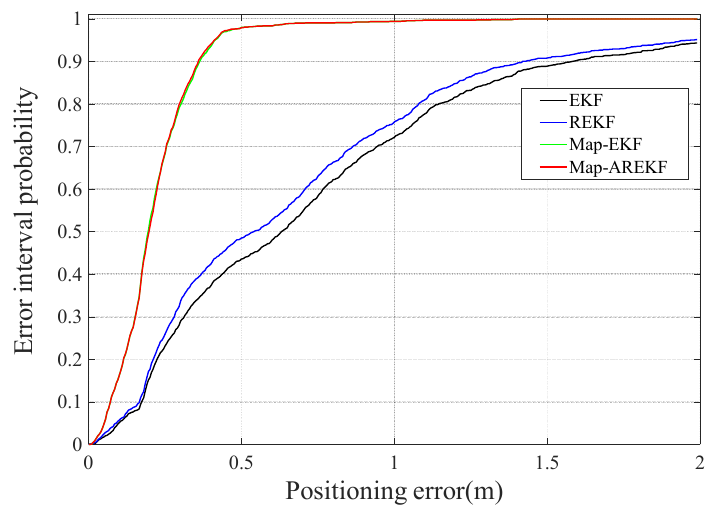
Figure 16. Probability statistics of algorithm localization error for Experiment 1.